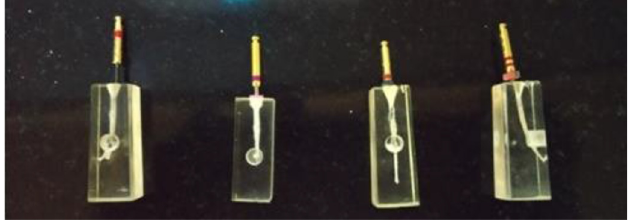
Fig. 9. Fractured samples during root canal preparation process.